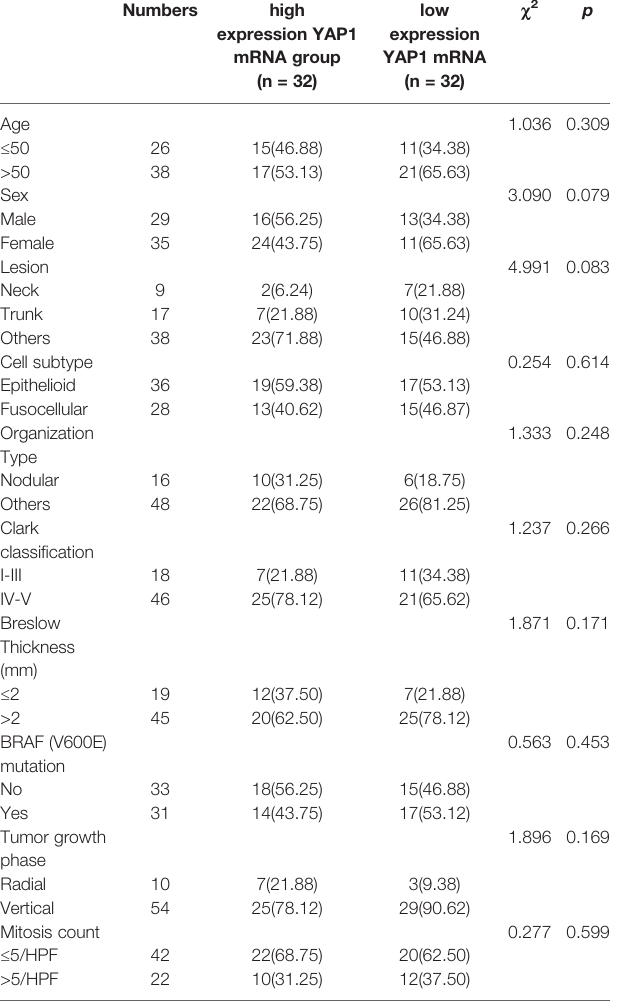
TABLE 3 | Relationship between YAP1 mRNA and clinicopathological characteristics of CMM